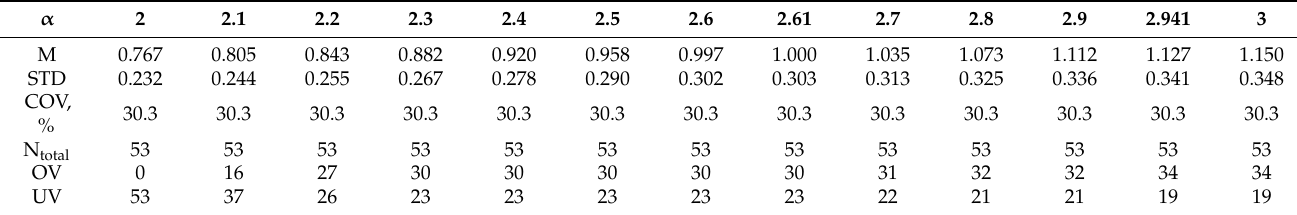
Table A9. The influence of α on the statistical results of L t.teor /L t.exp of all AFRP